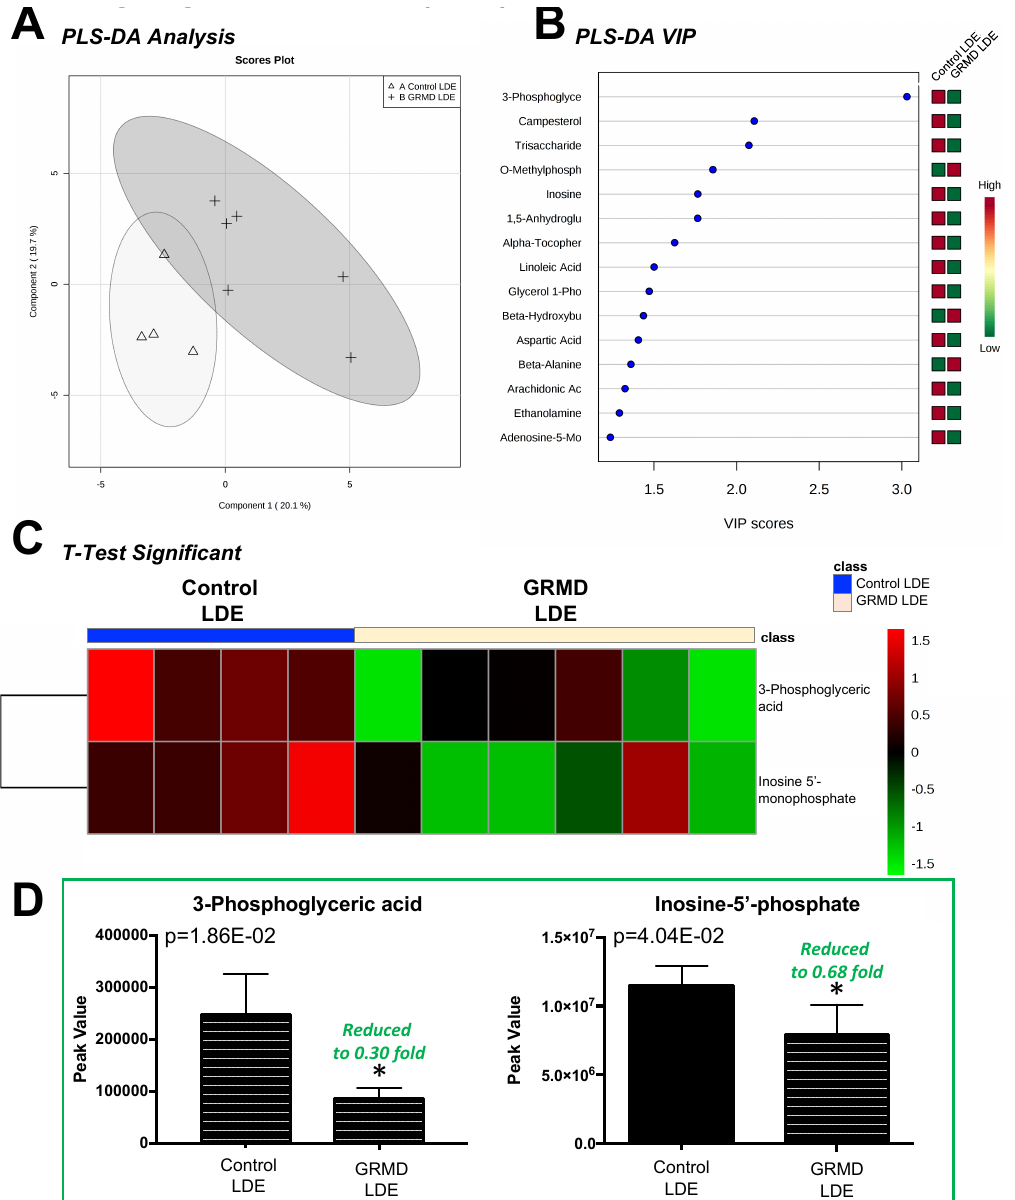
Figure 3. Figure 3. Untargeted metabolomics analysis of GRMD long digital extensor (LDE) muscle. ( A ) Supervised clustering of GRMD LDE metabolites using Partial least squares discriminant analysis (PLS-DA); ( B ) The top metabolites ranked by VIP scores; ( C ) Heatmap of t -test significant metabolites identified in GRMD BF vs. age-matched controls. Analysis by Metaboanalyst analysis of GRMD (N = 6) vs. control (N = 4) long digital extensor metabolites; ( D ) Peak values of significant metabolites identified in GRMD LDE vs. control